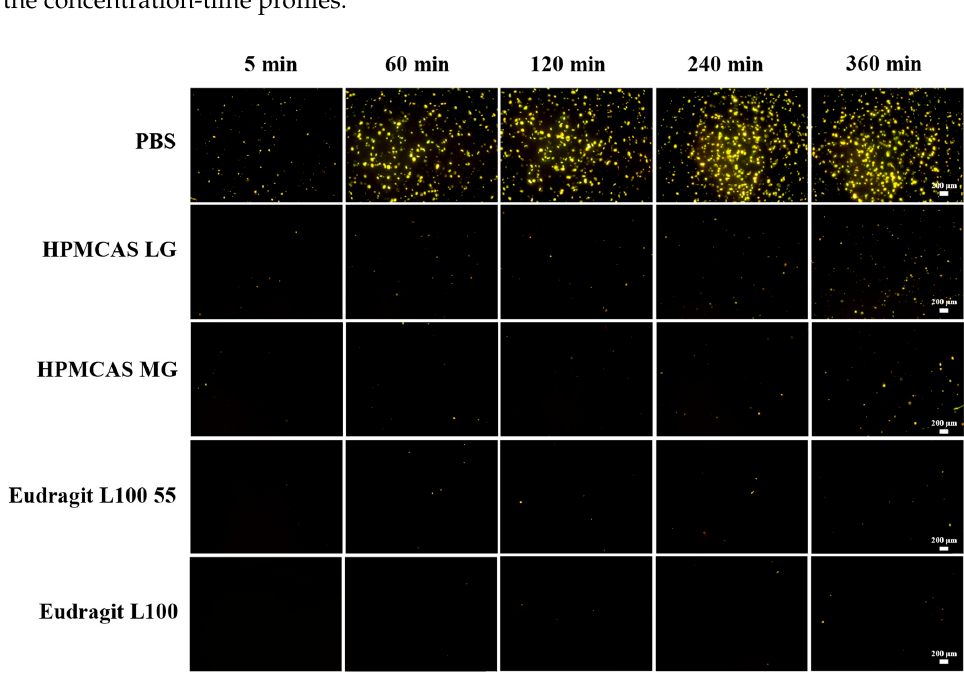
Figure 5. Crystallization of nintedanib in PBS with different polymers (scale bar = 200